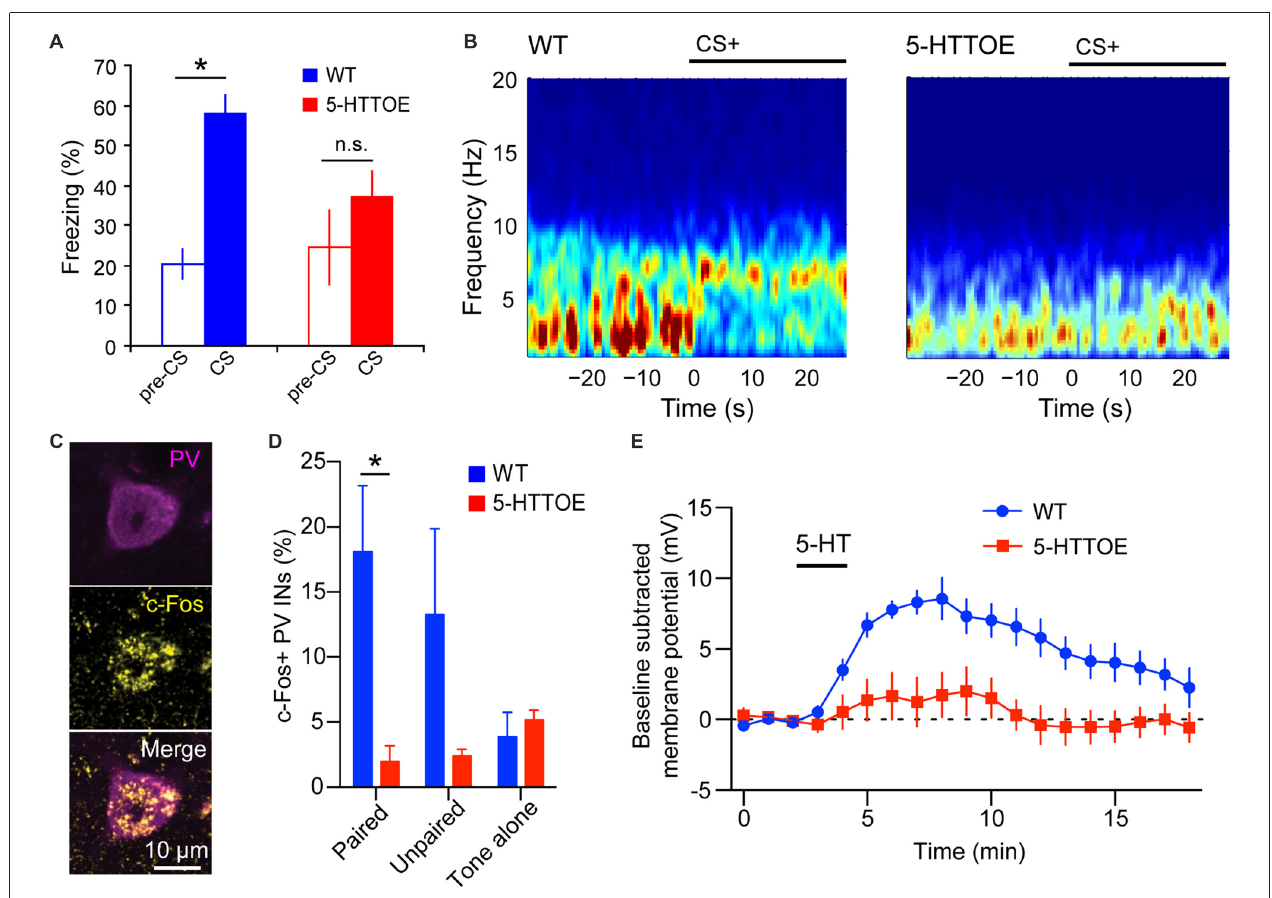
FIGURE 1 | Reduced basolateral amygdala (BLA) theta oscillations and recruitment of parvalbumin-expressing (PV) Interneurons (INs) in 5-hydroxytryptamine transporter over expressing (5-HTTOE) mice. (A) Wild-type mice (WT) exhibit significantly increased freezing during conditioned auditory tone conditioned stimulus (CS), whereas 5-HTTOE mice do not. (B) Representative spectrograms showing auditory cue-evoked oscillations in the BLA of a WT and 5-HTTOE mouse. CS+ presentation evokes a higher increase in oscillations in the theta band (5–12 Hz) in the BLA of the WT compared to the 5-HTTOE mouse. (C) Representative BLA PV+ neuron from a WT mouse that was activated by fear memory retrieval (c-Fos immunopositive). (D) BLA PV INs of WT mice are activated significantly more by fear memory retrieval than PV INs of 5-HTTOE mice. (E) BLA PV INs of WT mice display a much stronger depolarization than 5-HTTOE PV INs when 5-HT (50 µ M) is bath applied. ∗ p < 0.05. (A,B) Adapted from Barkus et al. (2014). (C–E) Adapted from Bocchio et al.